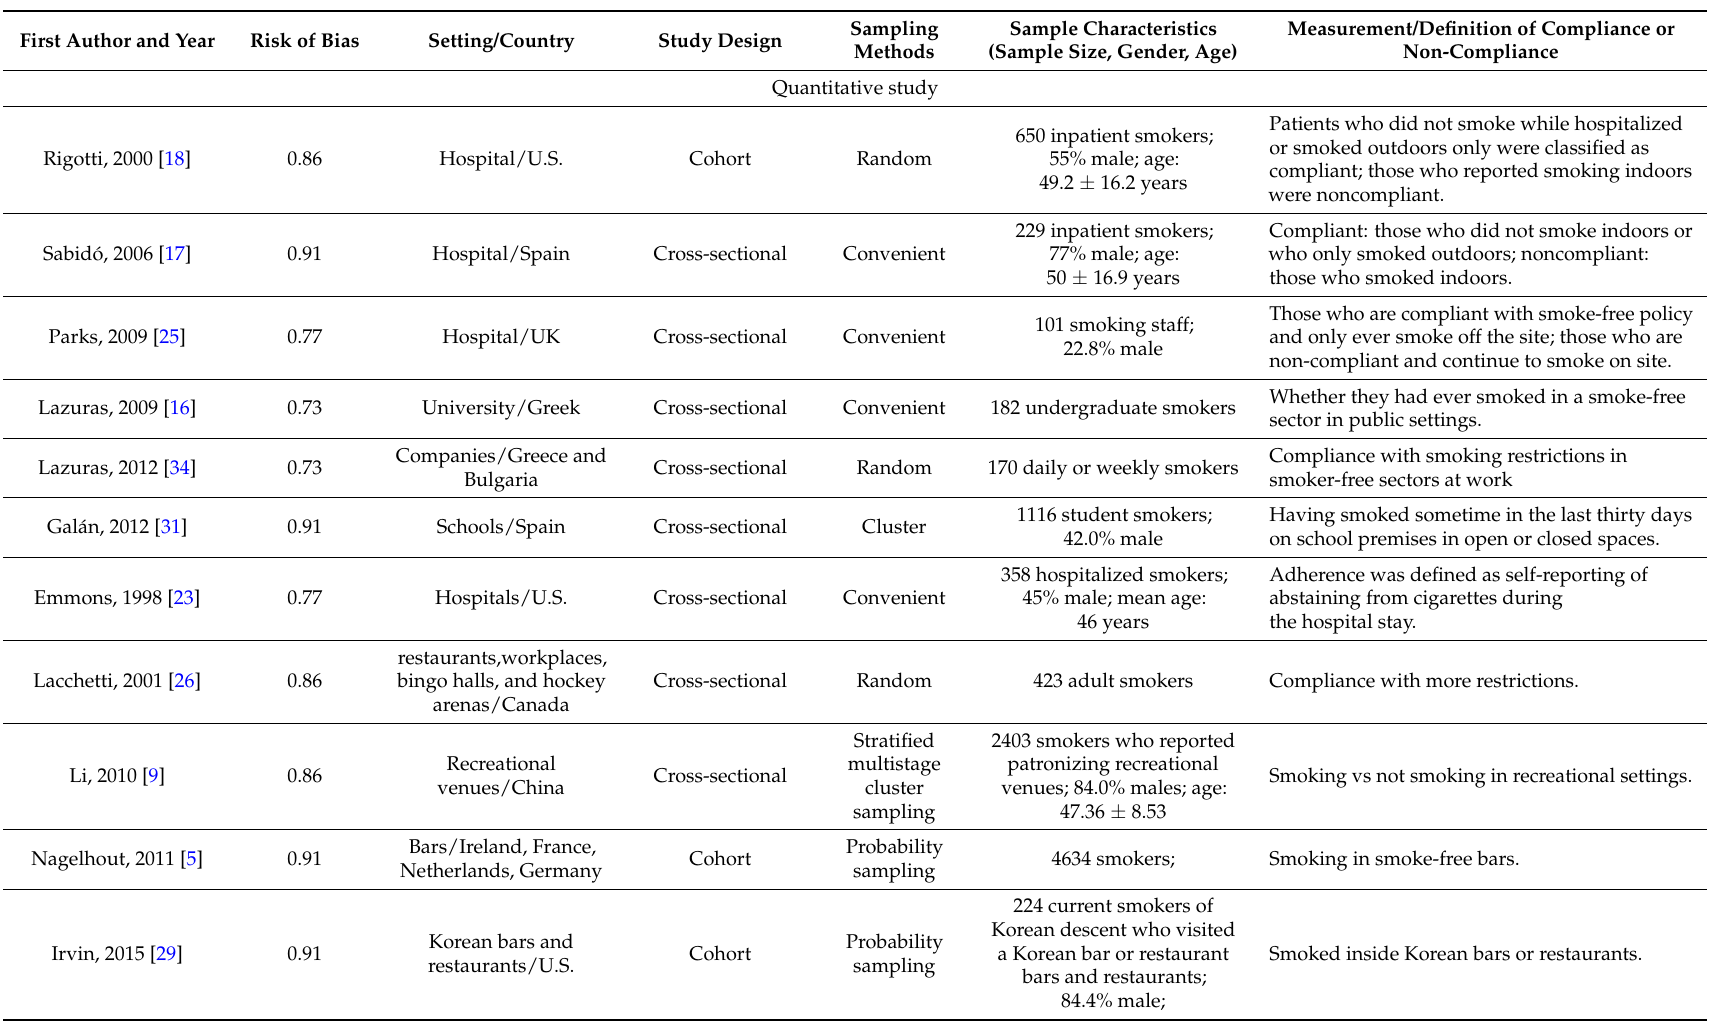
Table 1. Overview of included